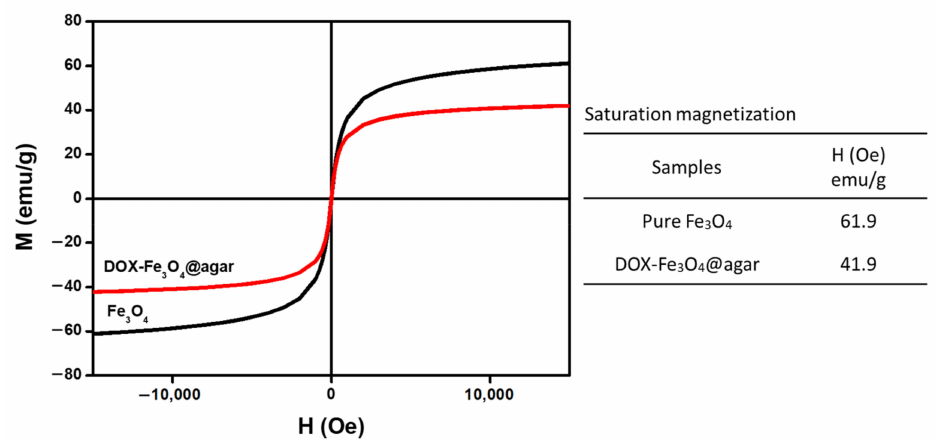
Figure 2. Magnetic strength of Fe 3 O 4 and DOX-Fe 3 O 4 @agar as measured by SQUID magnetometer.